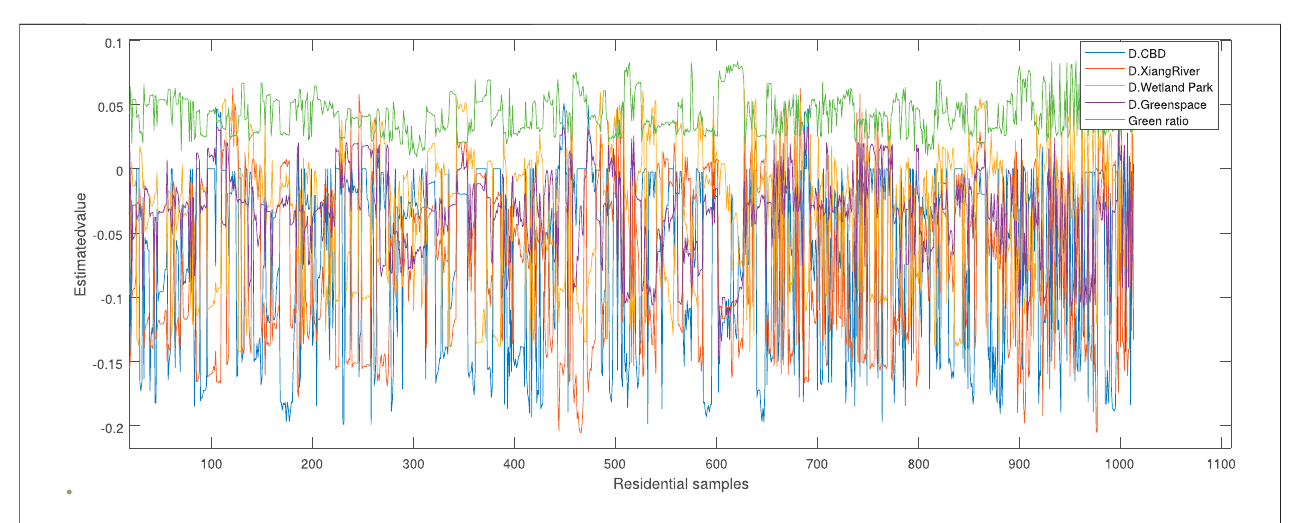
FIGURE 12 | Key coef fi cients divergence in